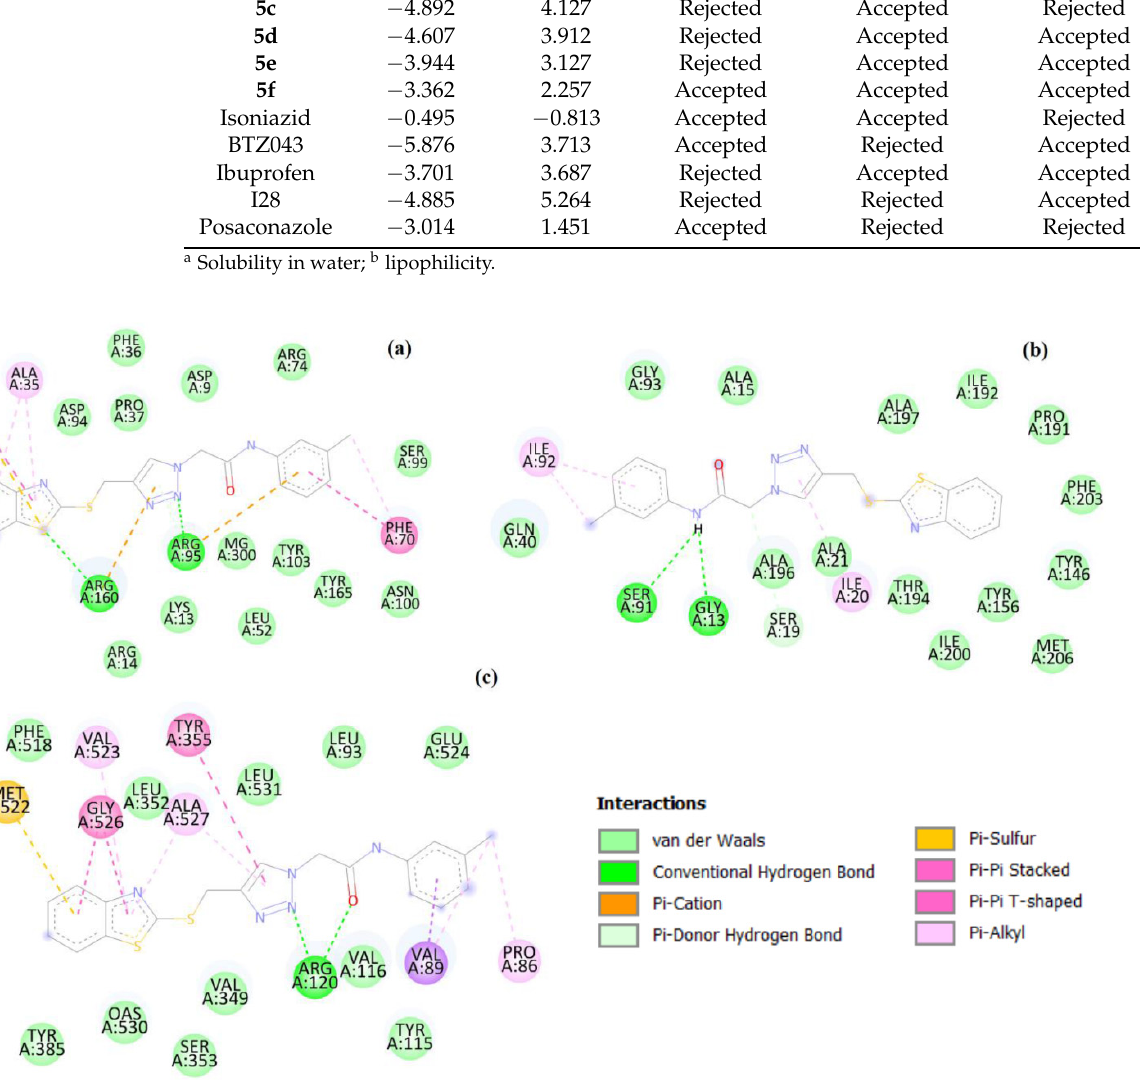
Figure 6. Two-dimensional illustrations of the interaction types between 5d and protein targets, 1G3U ( a ), 1QSG ( b ), and 5F19 ( c ).